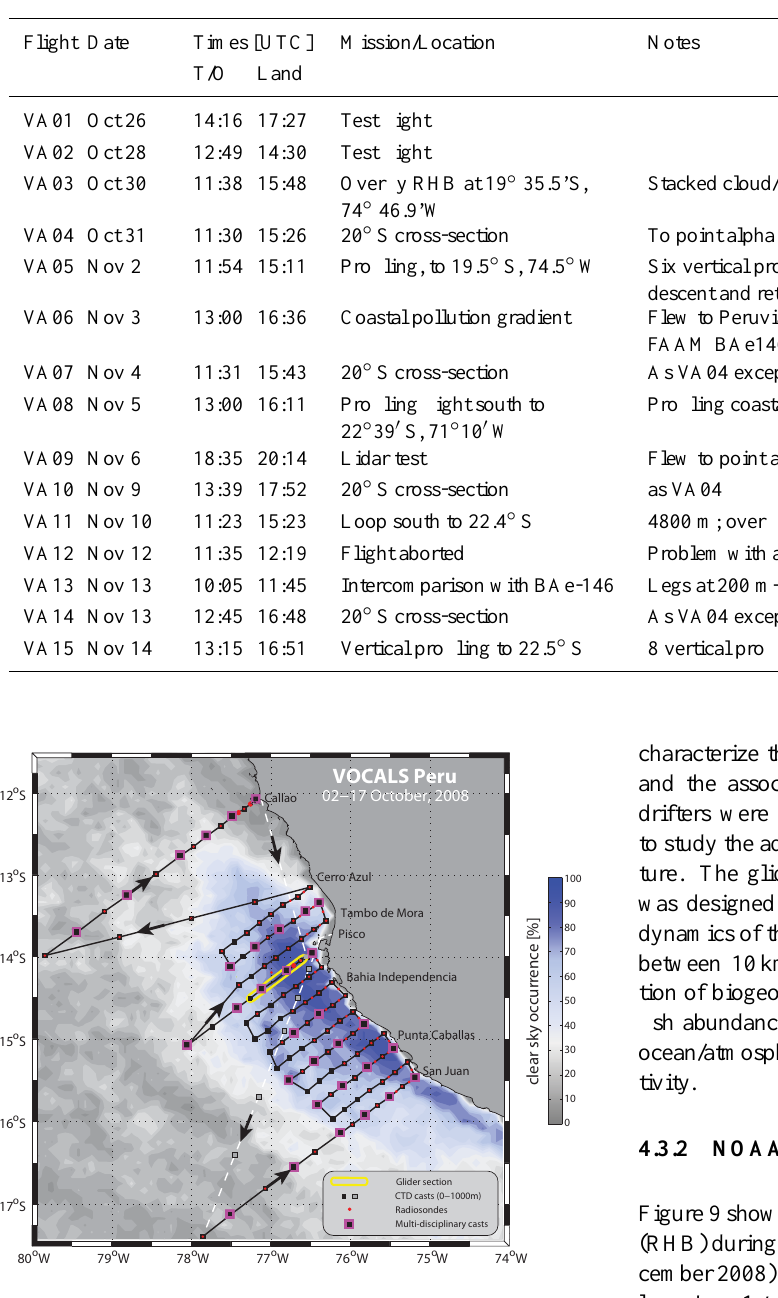
Fig. 8. Cruise track (black, with white for transit legs) and sam- pling from the IMARPE R/V Jos´e Olaya during the VOCALS Peru cruise (2–17 October 2008). The color contours show the October- mean (1997–2004) daytime clear sky fraction determined using the SeaWIFS cloud clearing